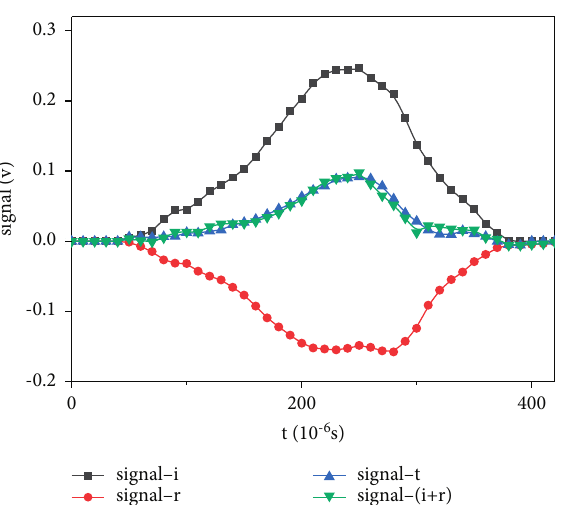
Figure 10: Typical incident, reflected, and transmitted waves.